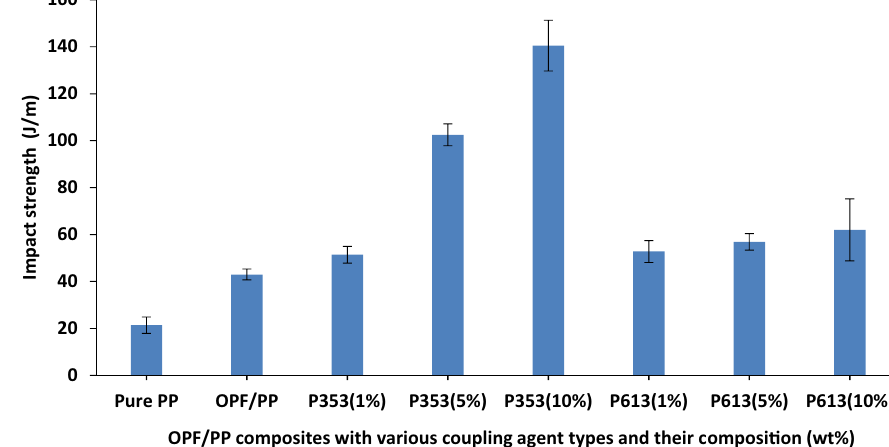
Figure 1: Impact strength of the pure PP, uncoupled, and coupled 20% OPF/PP polymer composite with two coupling agent types of di ff erent weight